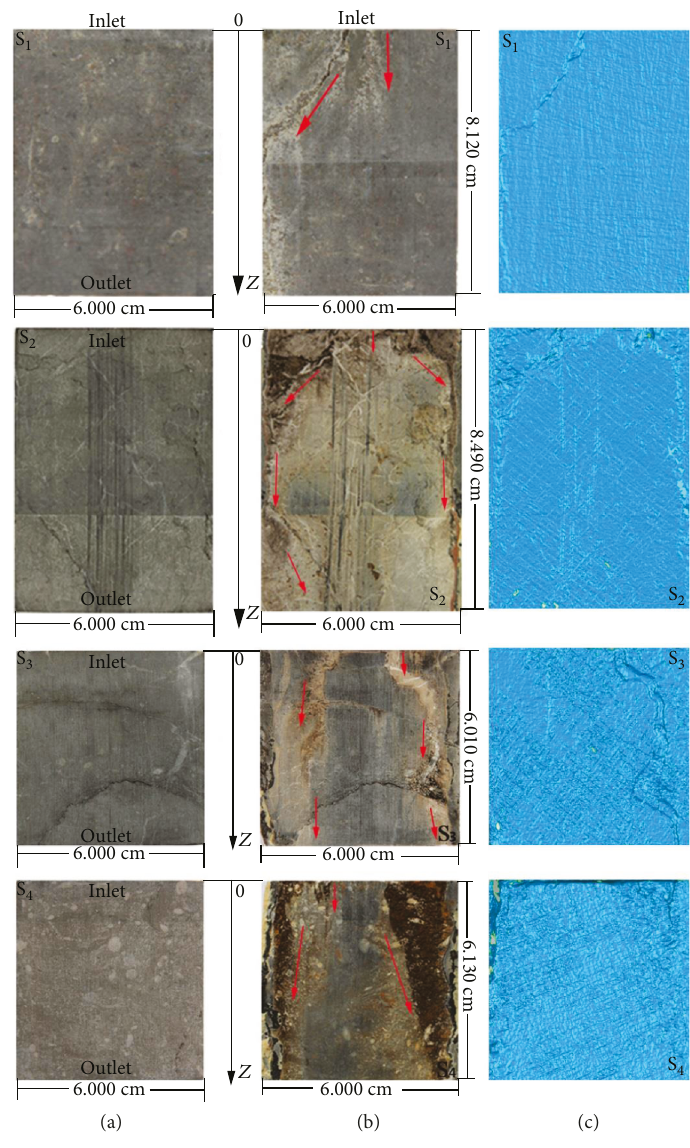
Figure 5: Photographs of the four fracture surfaces. Column (a) shows the photographs before the CFDE experiments. Column (b) shows the photographs after the CFDE experiments. Column (c) shows the fi gures of 3D-laser scanning after the CFDE experiments. The red arrow indicates the direction of fl ow paths and dissolution